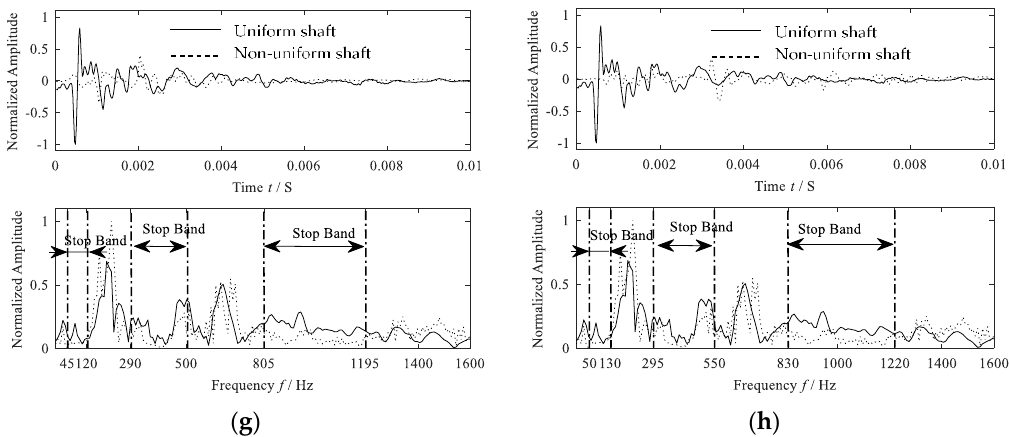
Figure 9. Experimental Stop Bands derived at different crack locations, where ( a ) is for location 0.1 L , ( b ) is for location 0.2 L , ( c ) is for location 0.4 L , ( d ) is for location 0.5 L , ( e ) is for location 0.6 L , ( f ) is location 0.7 L , ( g ) is for location 0.8 L and ( h ) is for location 0.9 L .